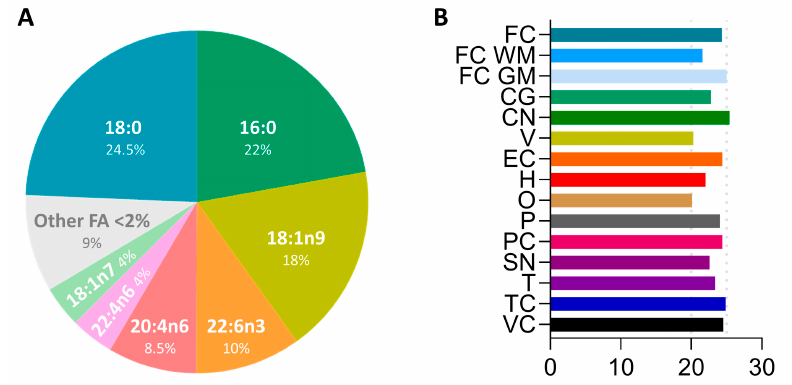
Figure 3. Fatty acid profile in the frontal cortex and oleic acid content (%) in different regions of the human brain. ( A ) Fatty acid distribution in human prefrontal cortex from healthy adult (middle-age) individual. Fatty acid analysis was performed in a gas chromatography system. Data obtained from [14]. ( B ) Oleic acid content (%) in different regions of the adult human brain. Data obtained from [14]. Brain regions: FC, frontal cortex; FC WM, frontal cortex white matter; FC GM, frontal cortex gray matter; CG, cingulate gyrus; CN, caudate nucleus; V, vermis; EC, entorhinal cortex; H, hippocampus; O, olive; P, putamen; PC, parietal cortex; SN, substantia nigra; T, thalamus; TC, temporal cortex; VC, visual (occipital)